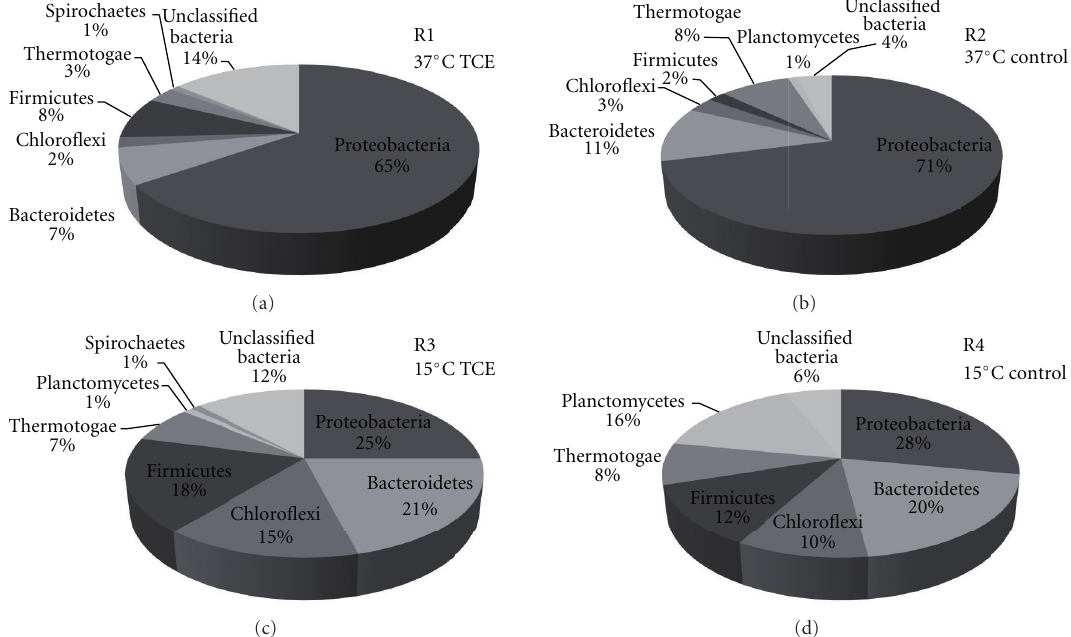
Figure 1: Diversity of bacterial clones obtained from 16S rRNA gene clone libraries. R1: 37 ◦ C TCE-supplemented; R2: 37 ◦ C control; R3: 15 ◦ C TCE-supplemented; R4: 15 ◦ C control.